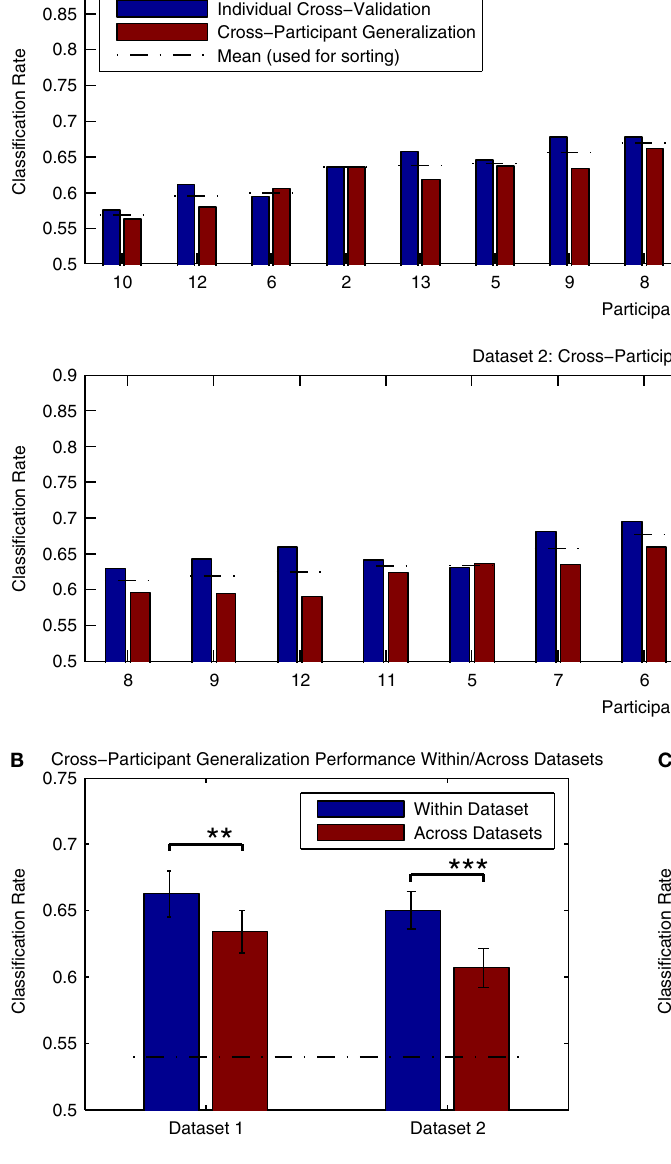
FIGURE 11 | Classifier generalization to novel participants and datasets. (A) Both datasets were used to perform a cross-participant analysis of generalization performance, in which a series of classifiers were trained using all but one participant’s data, and then tested on